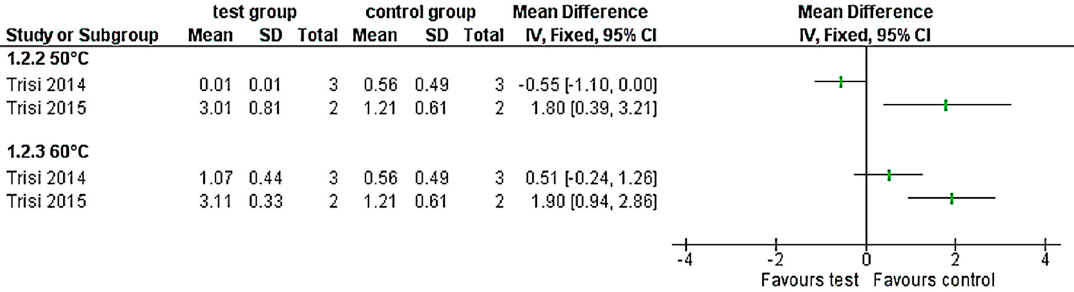
Figure 2. Forest-plots of the bone-to-implant contact ratio (%) values of the thermally treated implants (50 °C and 60 °C) compared with the control group.